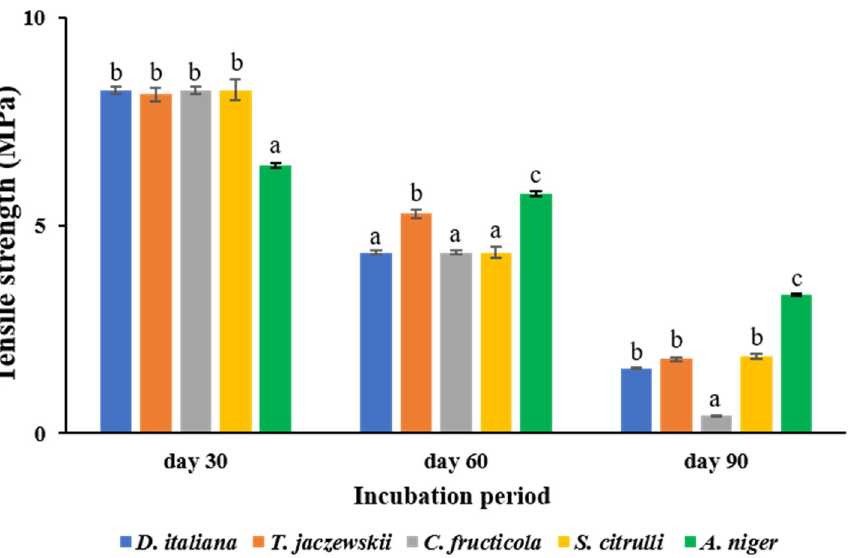
Figure 5. Tensile strength of LDPE films cultured with D. italiana , T. jaczewskii , C. fructicola , S. citrulli , and A. niger after 30, 60, and 90 days of incubation. Different letters above the bars indicate significant differences ( p < 0.05).